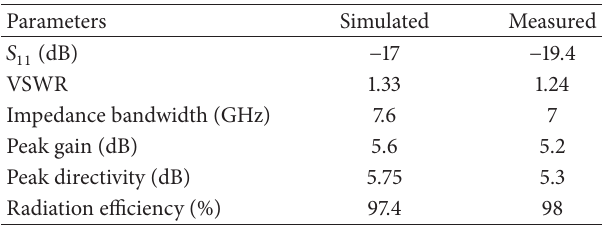
Figure 14: Horizontal cut of 3D measured radiation pattern at 10 GHz.